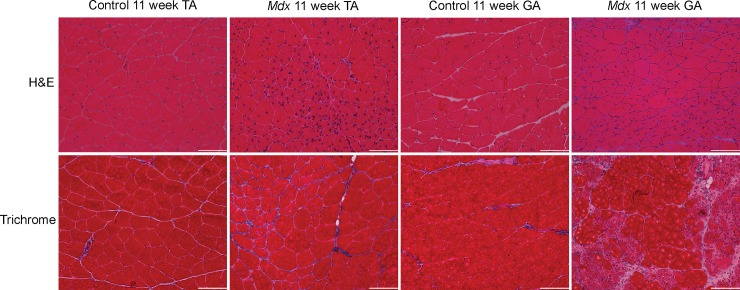
11-week comparison of TA and GA muscles of control and mdx4cv mice (both H&E and trichrome staining) at 20x magnification.Comparisons of representative histology images for both groups of animals (scale bar represents 100 μm).